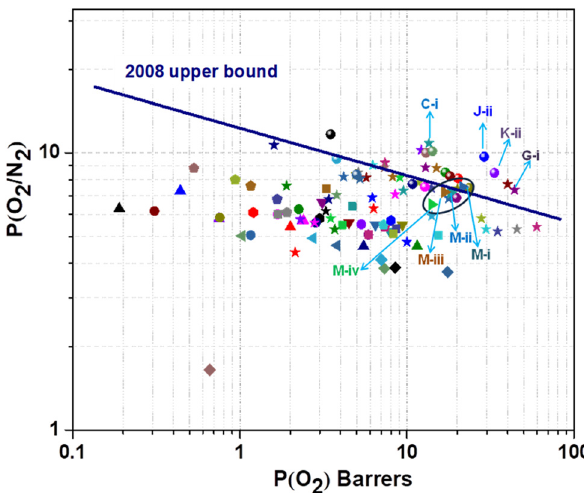
Figure 19: Robeson plot of permeability/selectivity trade - o ff for O 2 and N 2 gas pair. Values are taken from Tables 1 – 11.